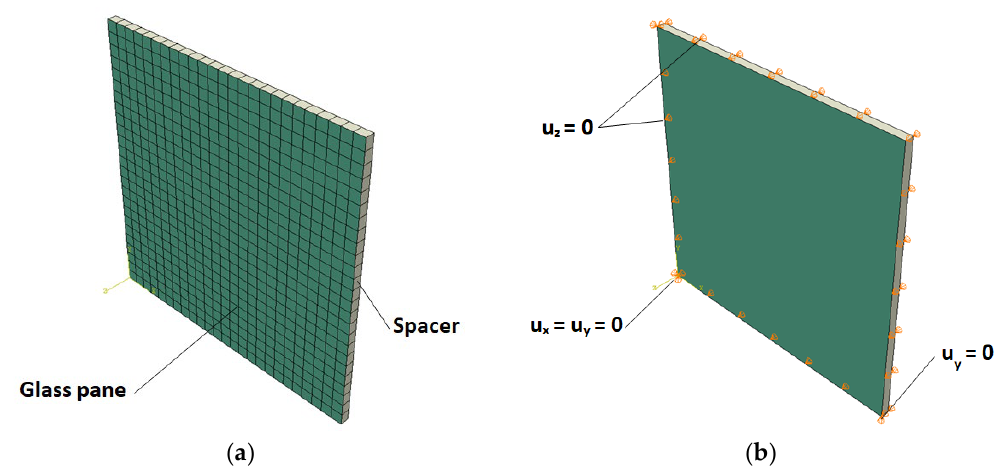
Figure 4. Reference FE model: ( a ) FE mesh; ( b ) mechanical boundary conditions.